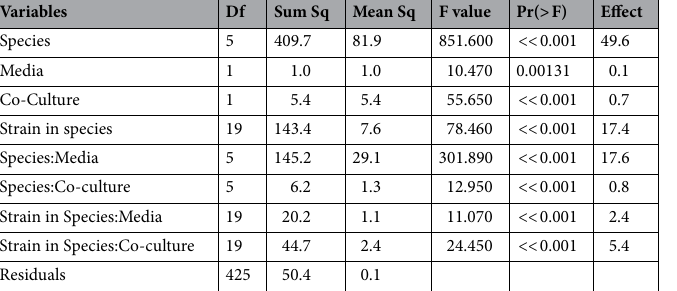
Table 1. The effect of experimental factors on the fungal daily radial growth rate. F(74, 425) = 109; p << 0.001; adjusted R 2 = 0.941. Effect represents the size of each effect calculated from the percentage of the sum of squares explained by the respective factor.